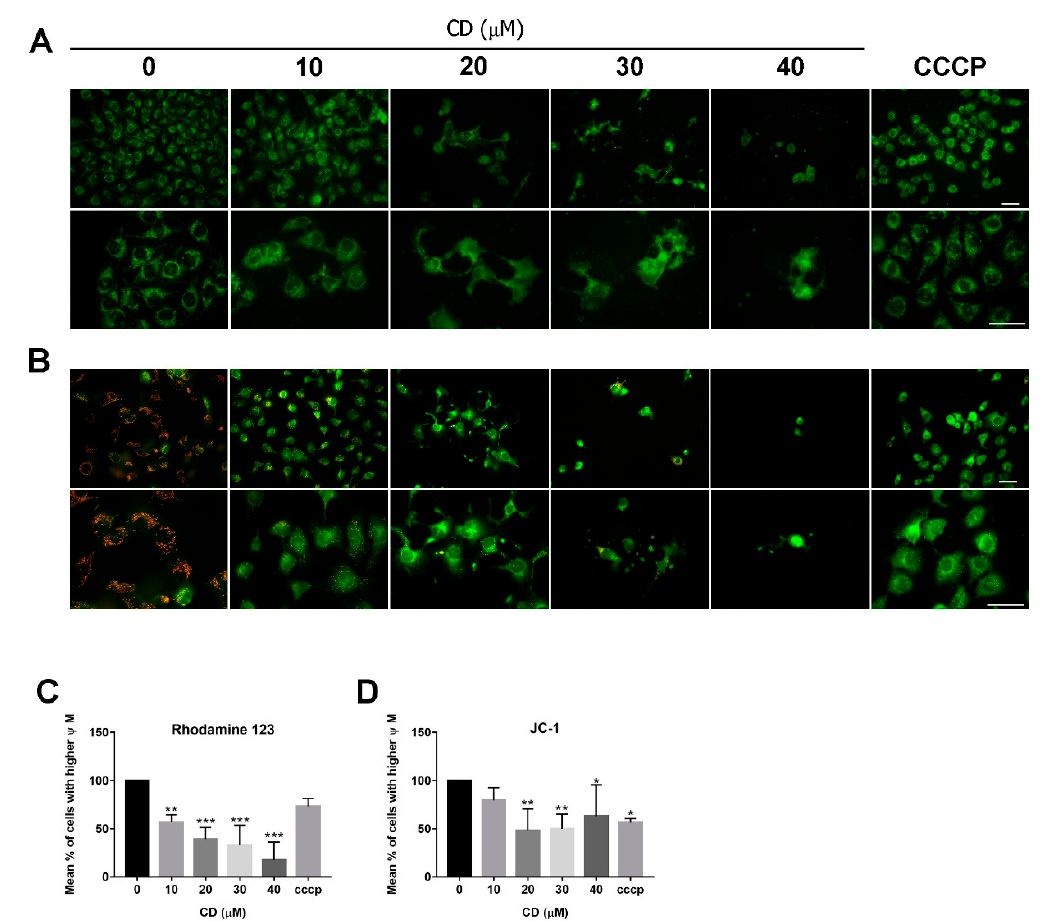
Figure 3. MMP is decreased after treatment with CD in T24 BC cells. Fluorescence staining of mitochondria by ( A ) Rh123 and ( B ) JC-1 at 200× and 400× magnifications. Scale bar = 50 µm. The representative photos were taken from one of the three independent experiments. Flow cytometry analysis of MMP by ( C ) Rh123 ( D ) JC-1 staining. Carbonyl cyanide 3-chlorophenylhydrazone (CCCP) was used as a positive control for confirming the successful inhibition of MMP. Bar graphs show values normalised as percentages relative to the control. Data are expressed as mean ± SD of three (Rh123) and four (JC-1) independent experiments. * p < 0.05, ** p < 0.01, *** p < 0.001 as compared with the control group (0 µM).